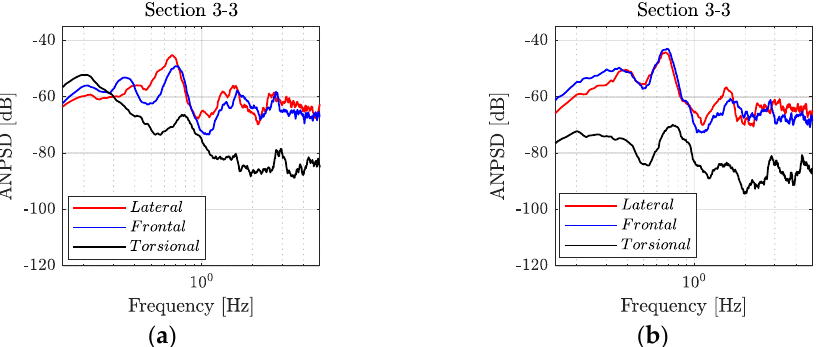
Figure 10. Frontal (y), lateral (x), and torsional vibrations estimated at Section 3-3 ( a ) in Test #3 and ( b ) Test #8.